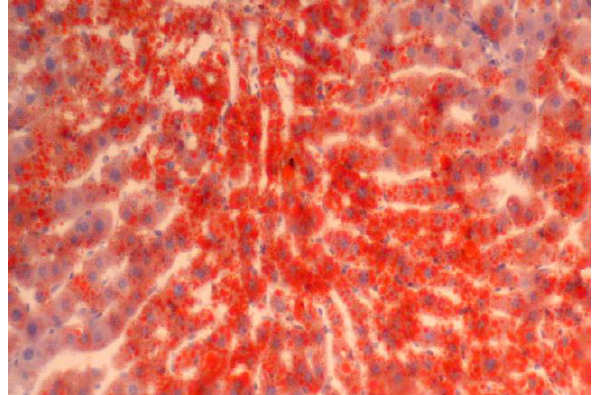
Fig. 4. Rat liver after ethanol administration. Neutral fat accumulation in cytoplasm of hepatocytes, frozen tissue slices, Sudan ΙV. ×200